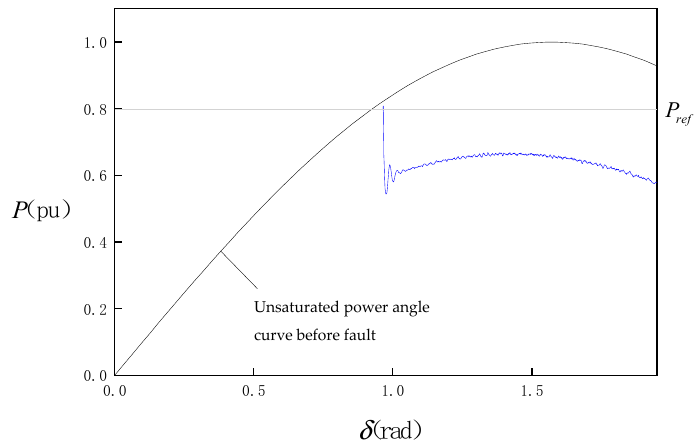
Figure 13. Simulation results of medium voltage sag while X Σ is 0.3 pu. When the line impedance is large (X Σ = 1 pu), the simulated power-angle curve is shown in Figure 14. It can be seen that when the voltage sag occurs, the power angle continues to increase, and the converter cannot maintain synchronism with the grid which leads to synchronizing instability. But at this time, the output current of the converter is not saturated.